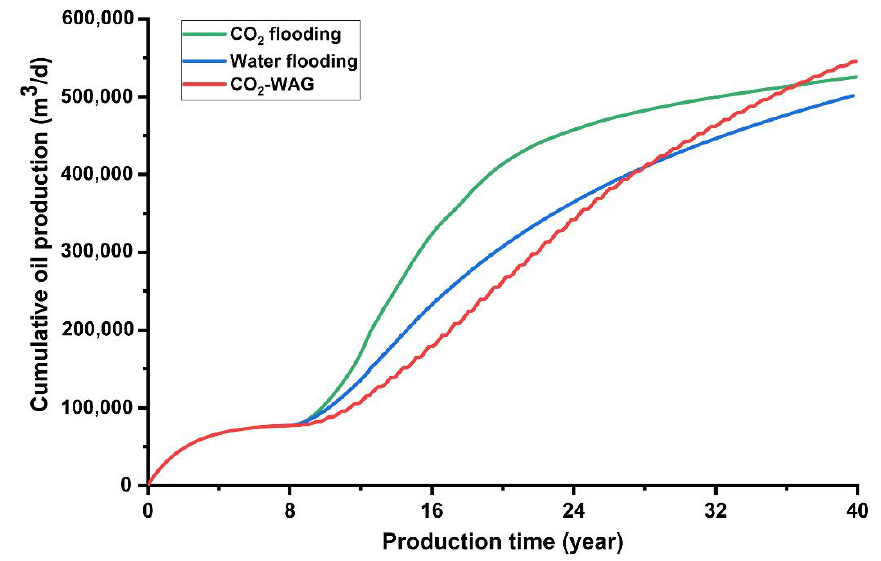
Figure 7. Cumulative oil production of CO 2 -WAG, CO 2 flooding and water flooding.